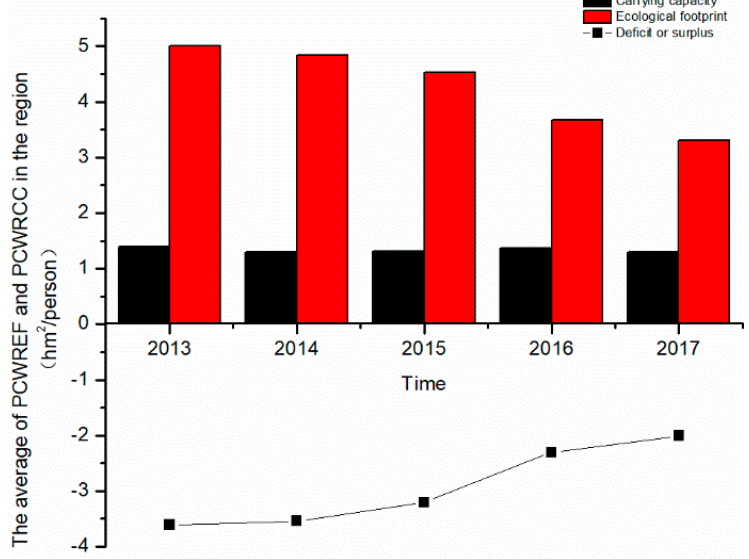
Figure 5. Trends of per capita water resources ecological footprint (PCWREF) and per capita water resources carrying capacity (PCWRCC) in the lower reaches of the Yellow River from 2013 to 2017.